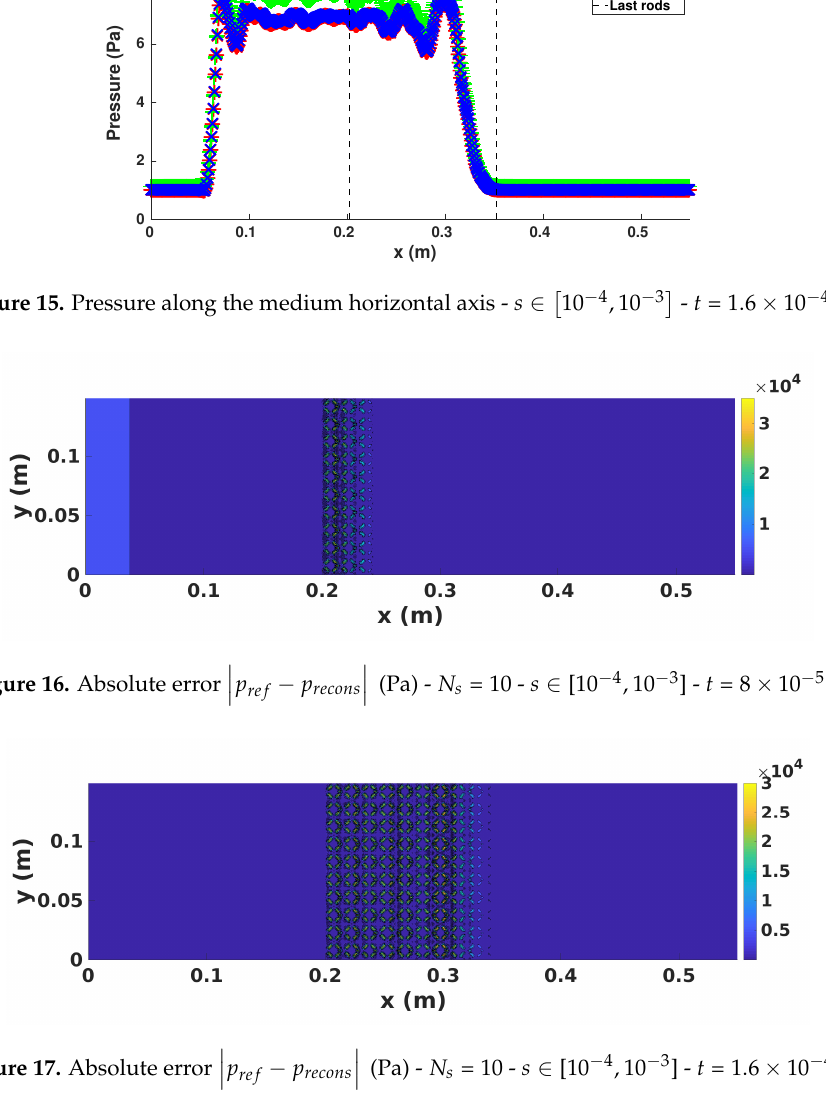
Figure 17. Absolute error